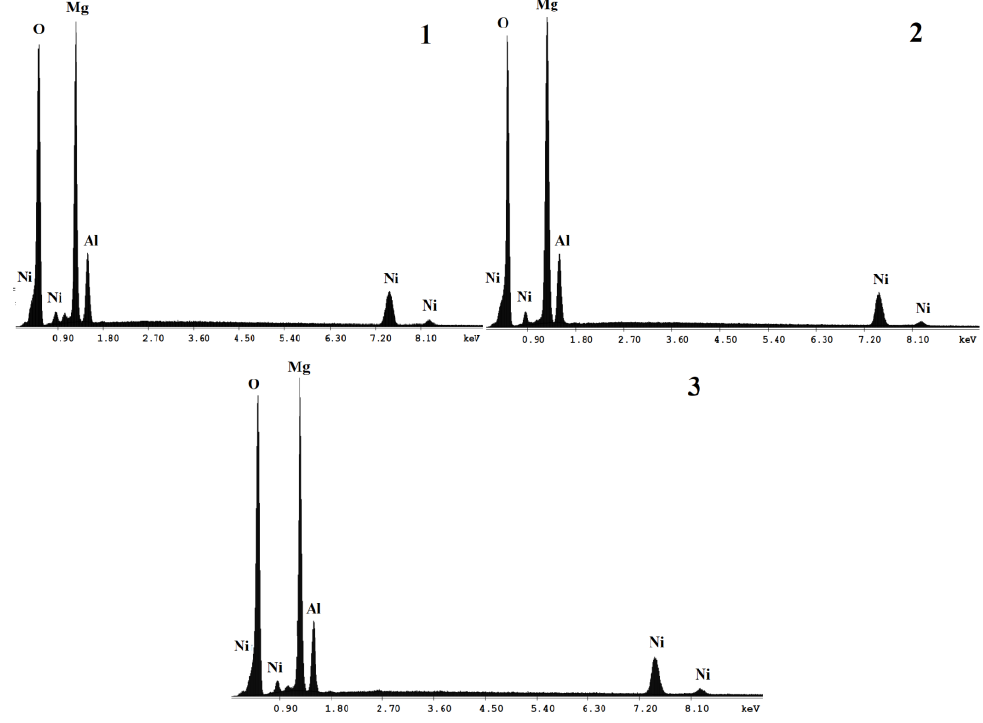
Figure 2. EDX spectra of samples: ( 1 ) Mg/AlNi 25-c, ( 2 ) Mg/AlNi 25-ht, ( 3 ) Mg/AlNi 25-mw .